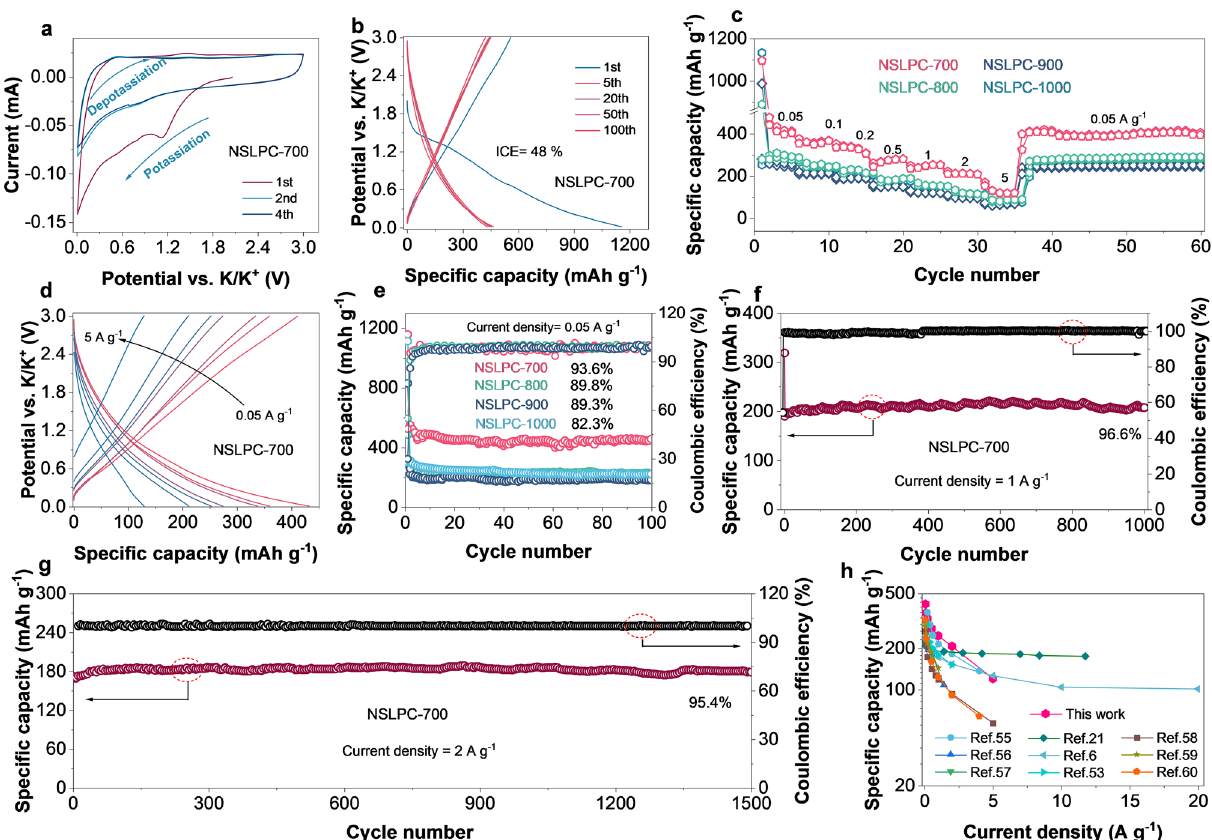
Fig. 5 a CV curves of the NSLPC-700 anode at a scan rate of 0.1 mV s −1 . b GCD curves of NSLPC-700 at 0.05 A g −1 . c Rate performances of NSLPCs. d GCD curves at different current densities. e GCD cycling performances of NSLPCs at 0.05 A g −1 over 100 cycles. f Long-term GCD cycling performance of NSLPC-700 at 1 A g −1 over 1000 cycles. g Long-term cycling performance of NSLPC-700 at 2 A g −1 over 1500